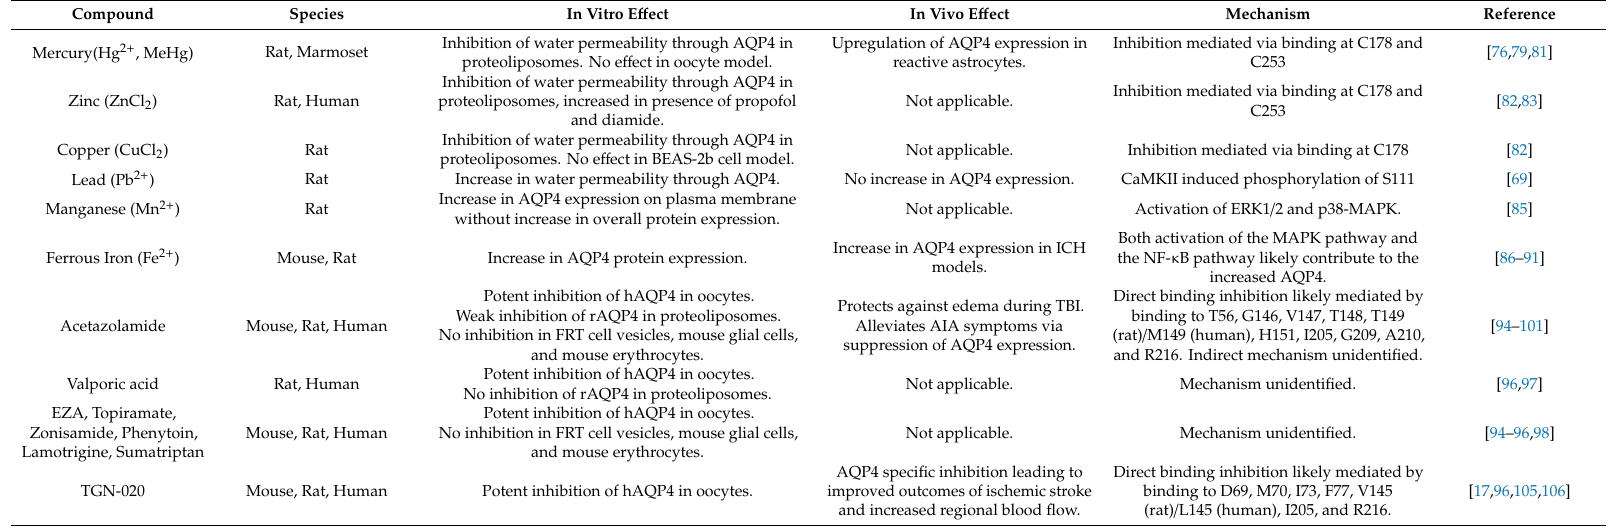
Table 2. An overview of the metal ions and small molecule inhibitors discussed in this review, including the species of AQP4 tested, the e ff ect the molecule had in in vitro testing, the e ff ect the molecule had in in vivo testing (where applicable), and the proposed mechanism of action of the molecule. Compound Species In Vitro E ff ect In Vivo E ff ect Mechanism Reference Rat, Marmoset Upregulation of AQP4 expression in reactive